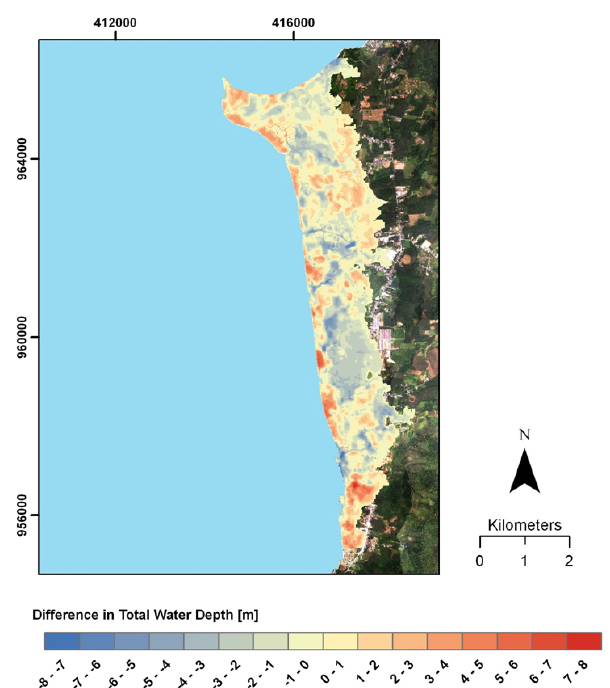
Fig. 9. Difference image between inundation simulations based on ASTER GDEM and MFC DEM ref .